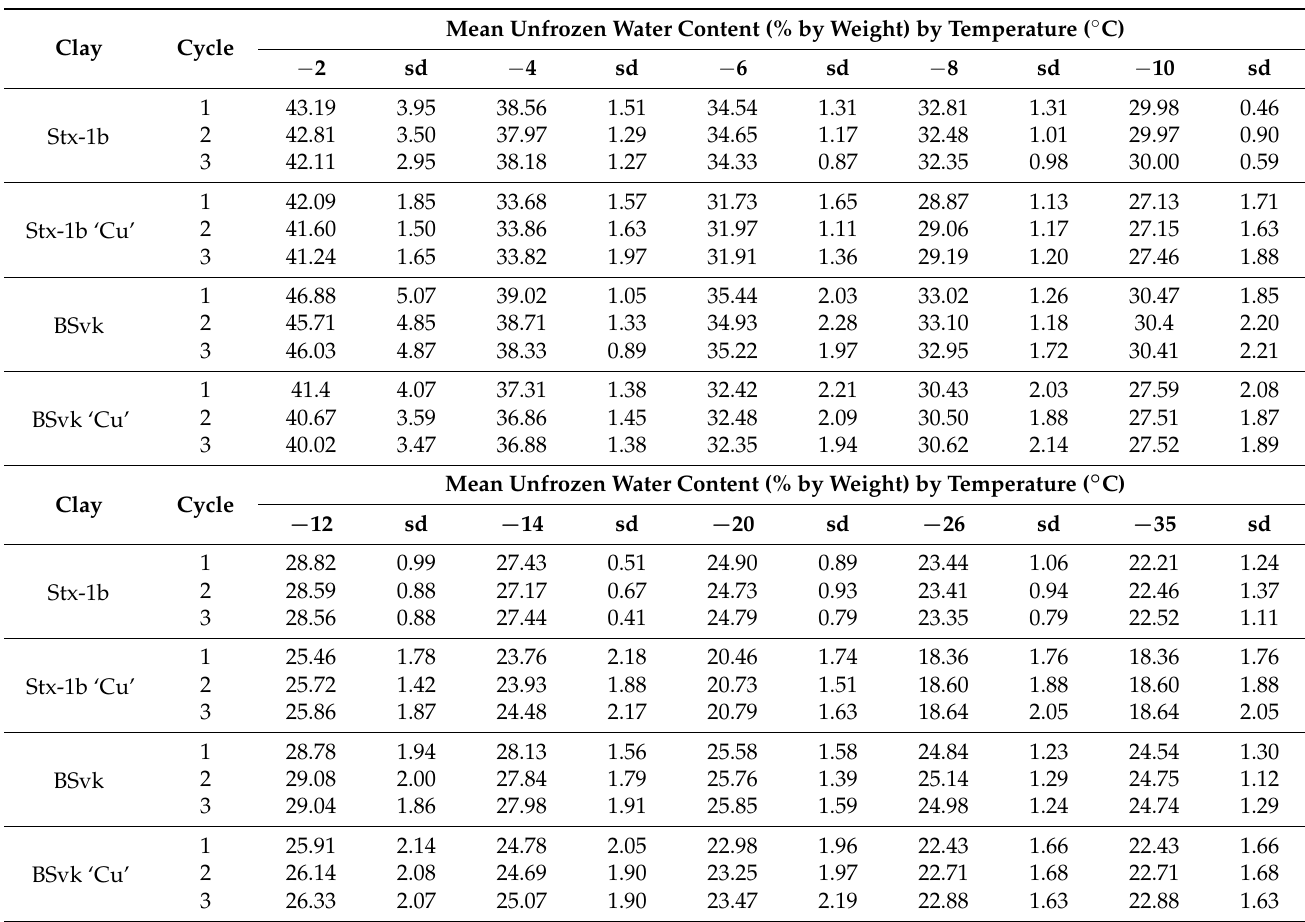
Table 3. The mean unfrozen water content at a given negative temperature in the 1–3 melting cycle, depending on the clay type.